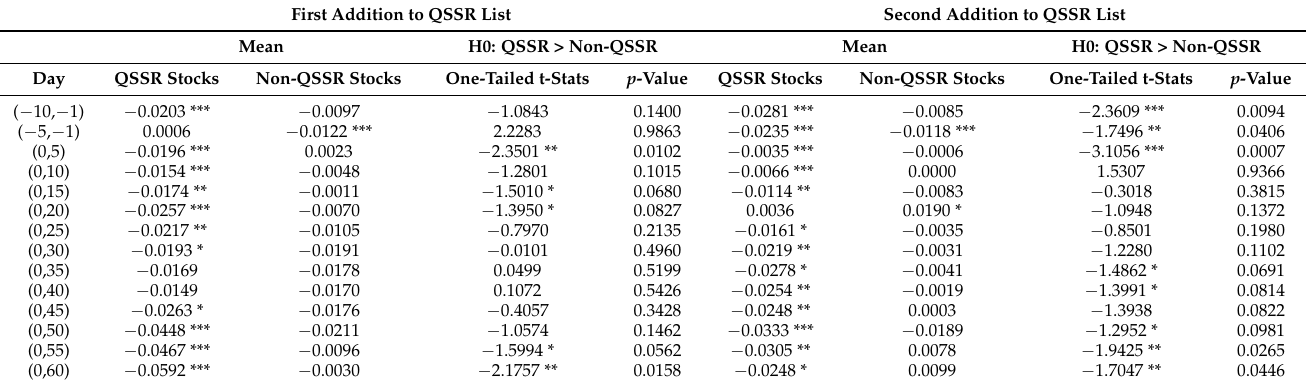
Table 10. Cumulative abnormal returns (CARs) around additions to the QSSR